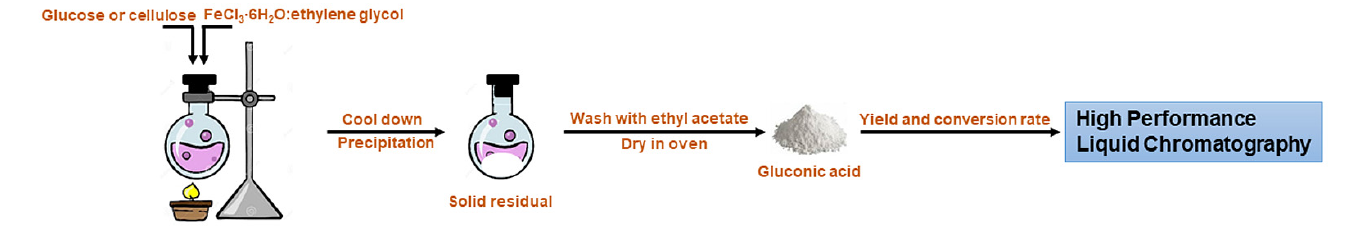
Figure 5. The experimental procedure to obtain gluconic acid from glucose or cellulose.